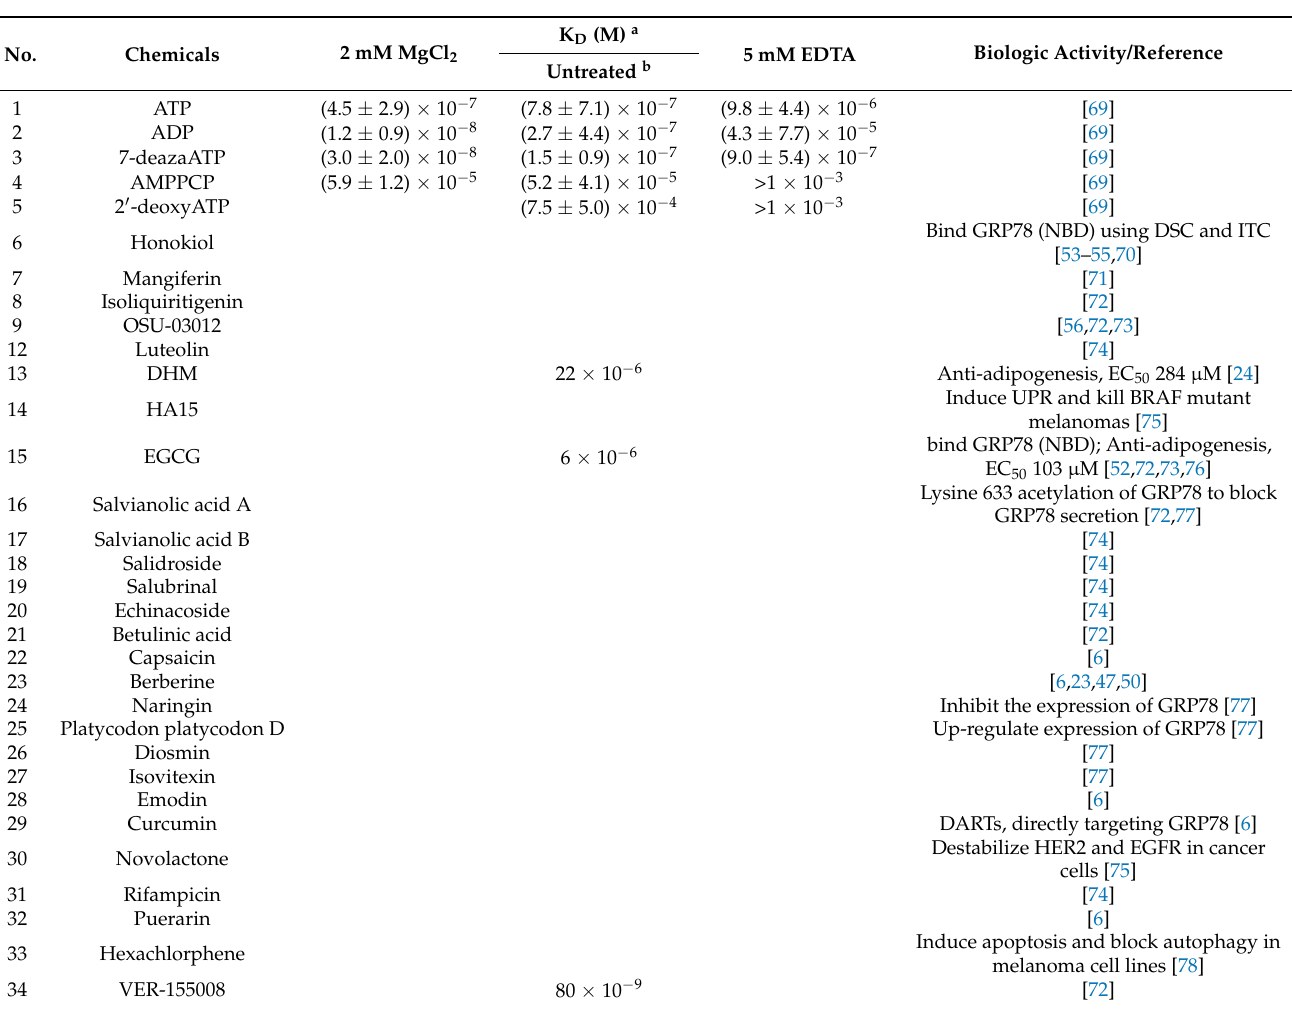
GRP78 ATPase nucleotide affinities (K D ) determined by surface plasmon